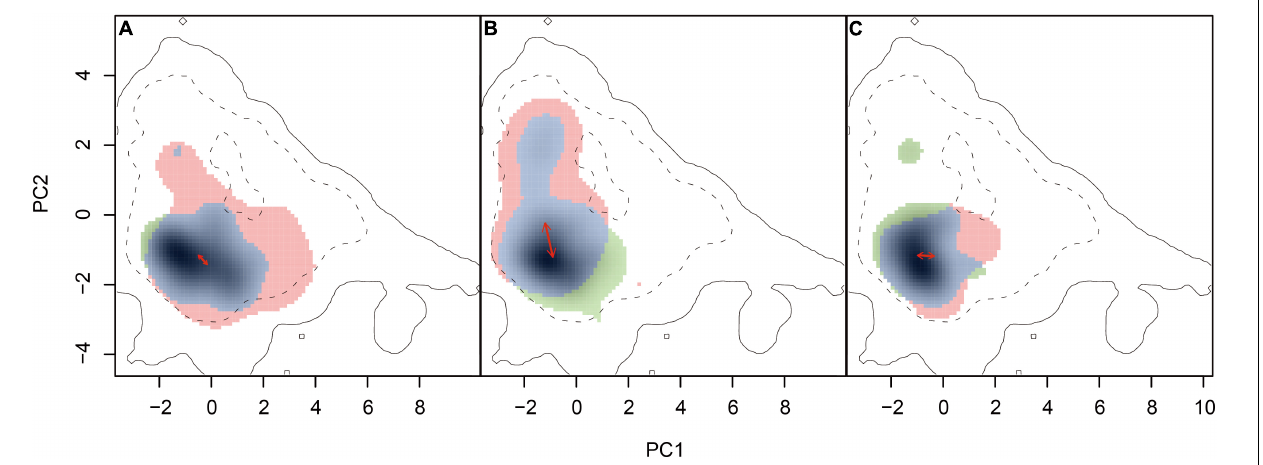
FIGURE 3 | Niche overlap between related species. (A) Myriophyllum , (B) Stuckenia , and (C) Ranunculus . The solid and dashed contour lines indicate 100 and 50% of the available environmental data for the whole study region as backgrounds. The unique niches of widespread species (red: M. spicatum , S. pectinate , and R. trichophyllus ), the unique niches of boreal species (green: M. sibiricum , S. filiformis , and R. subrigidus ), and the overlap (blue) were represented, respectively. The solid arrows represent the differences in the niche density center between parental species.